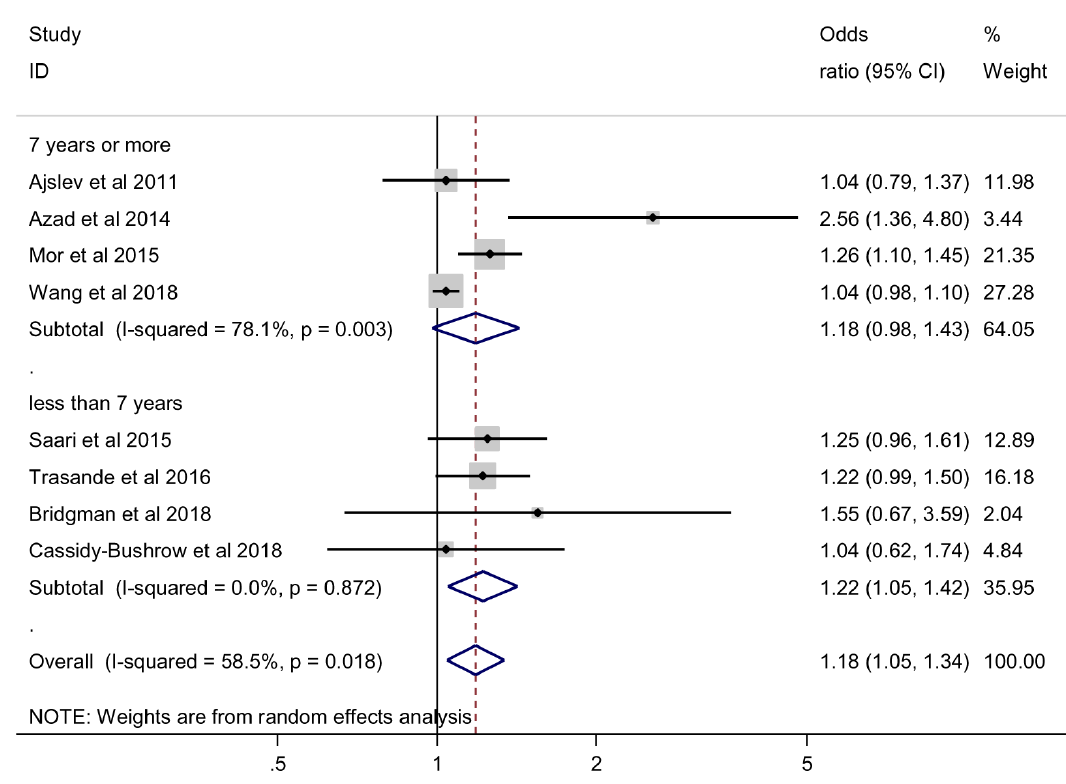
Figure 5. Overweight outcome, subgroup analysis by time-point of outcome assessment.